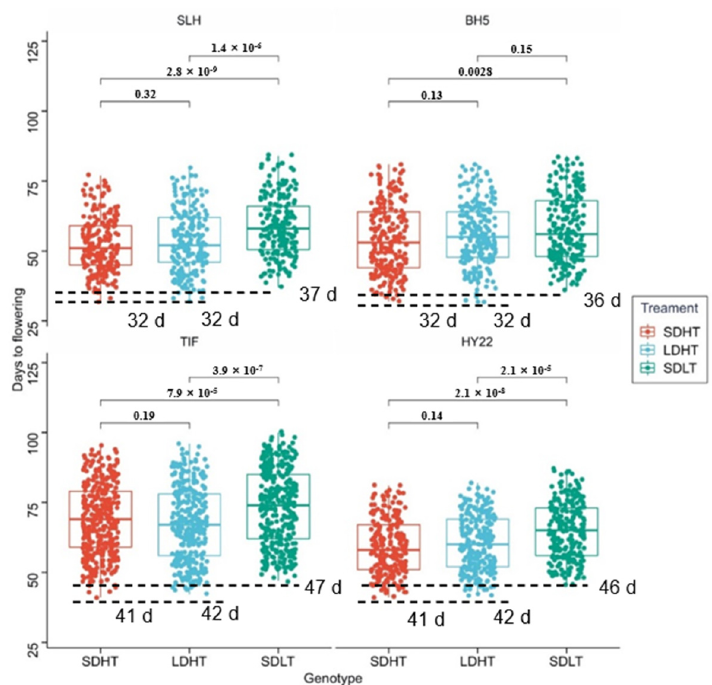
Figure 7. Responses of early and late-flowering genotypes under different temperature and photoperiod treatments; the horizontal axis represents the treatments, respectively, the vertical axis represents time (days) and each point represents the flowering time of each flower. The Kruskal-Wallis test was used to compare the distribution of flowering period under different treatments. Three different environmental conditions were set, long days and high temperatures (LDHT), short days and high temperatures (SDHT) and short days and low temperatures (SDLT).